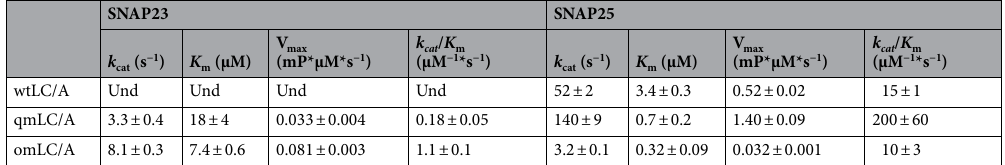
Table 1. Enzyme kinetics of LC/A variants. Kinetic constants of recombinantly expressed and purified LC/A variants were determined via the DARET assay 25 with modifications as described in the Materials & Methods . Values are means ± SEM (n = 3) and und =